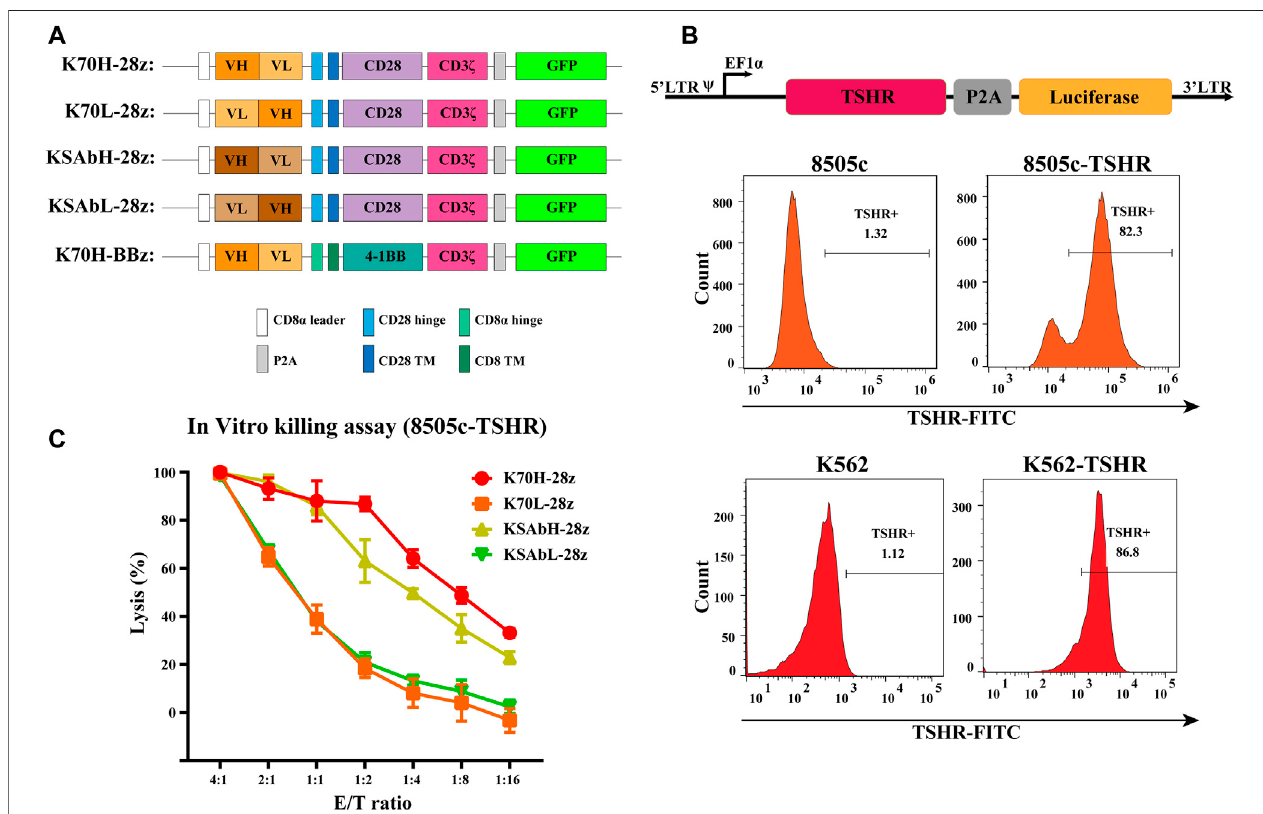
FIGURE 1 | Design of TSHR-speci fi c CARs. (A) Construction of CARs with different scFvs and co-stimulatory domains. TM: transmembrane. (B) Generation of 8505c and K562 cell lines expressing TSHR antigen. (C) In vitro killing assay of primary CAR-T cells with different scFvs. Error bars: mean ± SD.